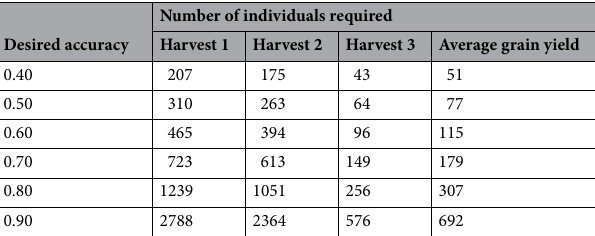
Desired accuracy